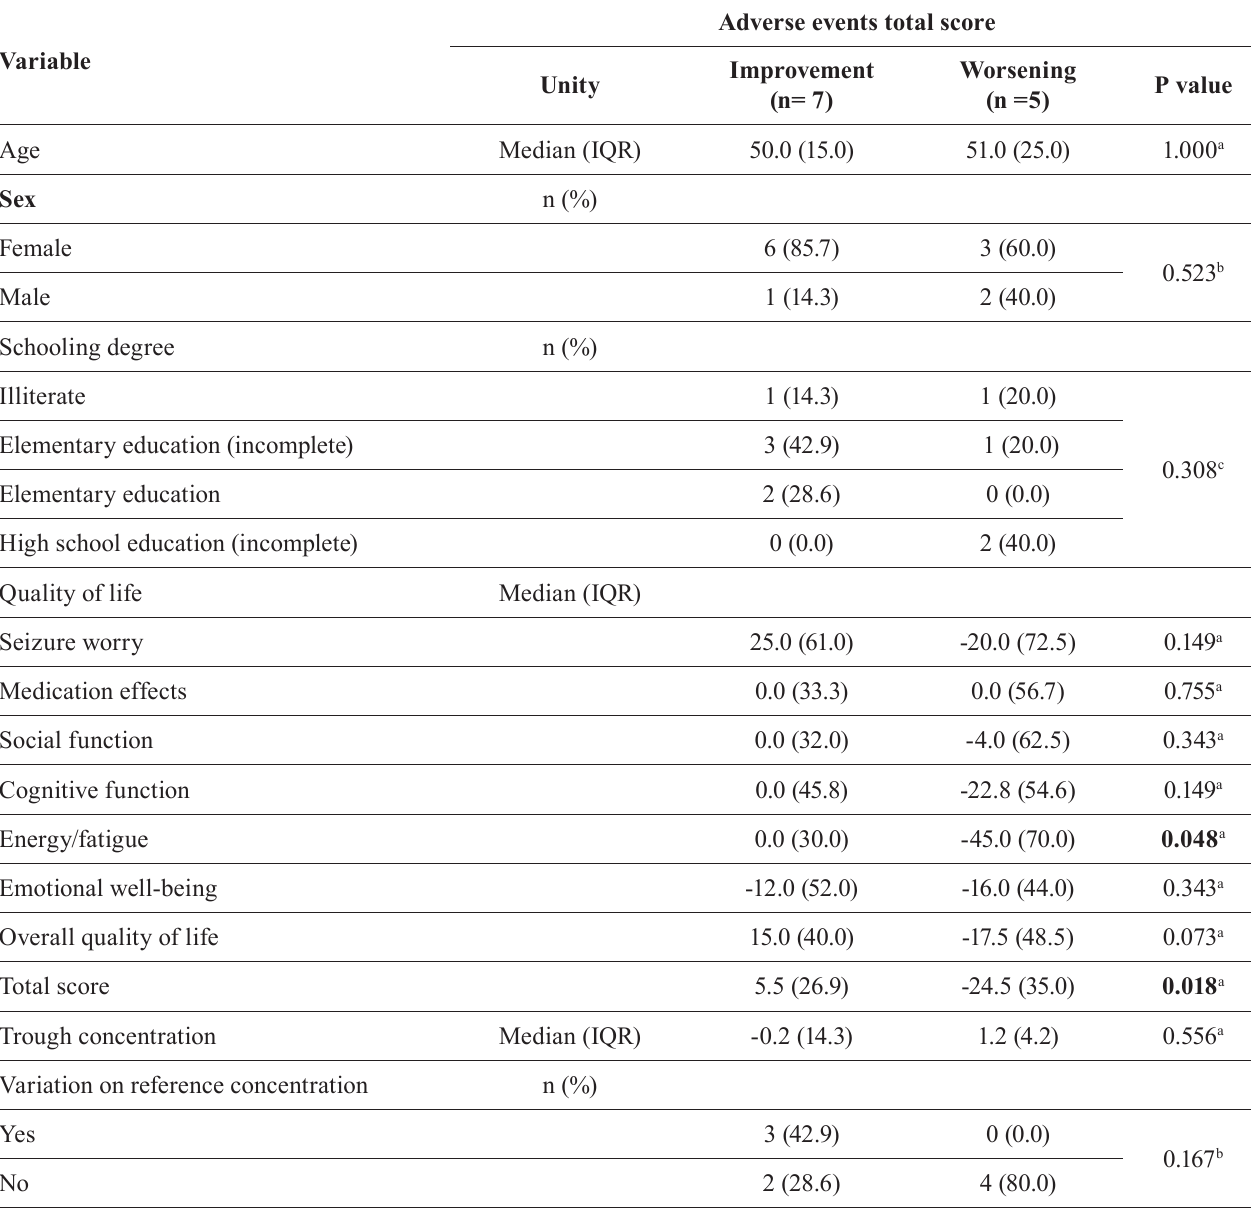
TABLE III - Analysis on the association of the following factors: age, sex, schooling degree, quality of life, trough concentration and variation on reference plasma carbamazepine concentration with improvement/worsening of adverse events (n=12)